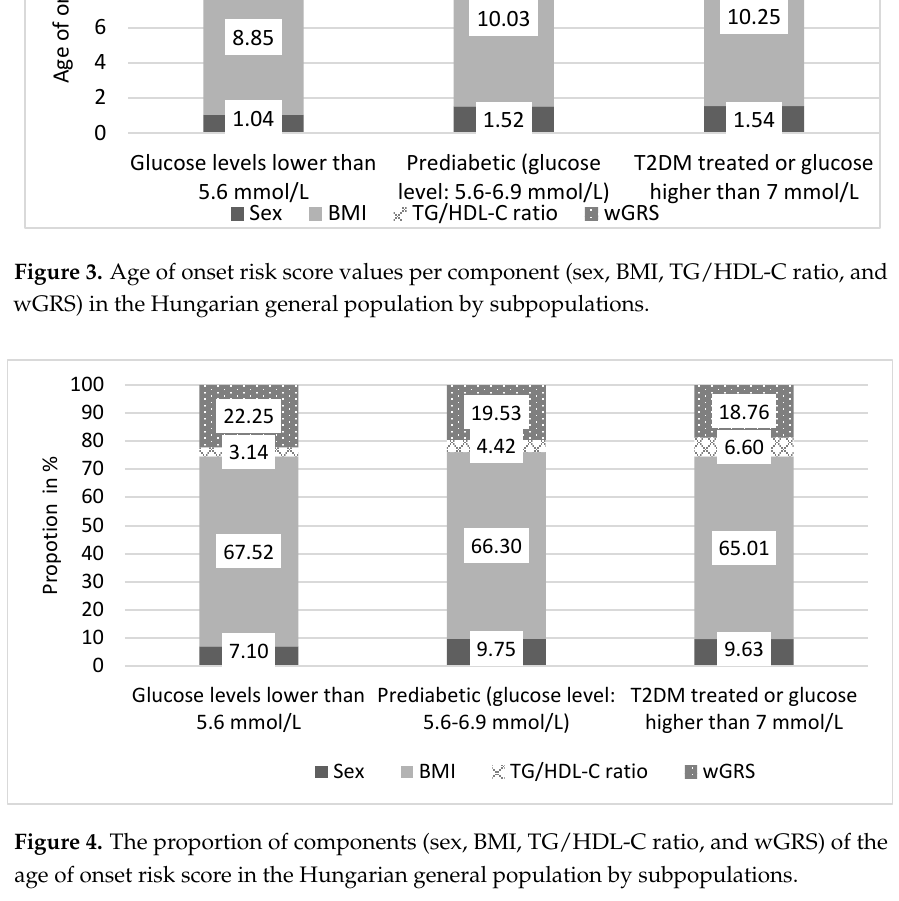
Figure 3. Age of onset risk score values per component (sex, BMI, TG/HDL-C ratio, and wGRS) in the Hungarian general population by subpopulations.